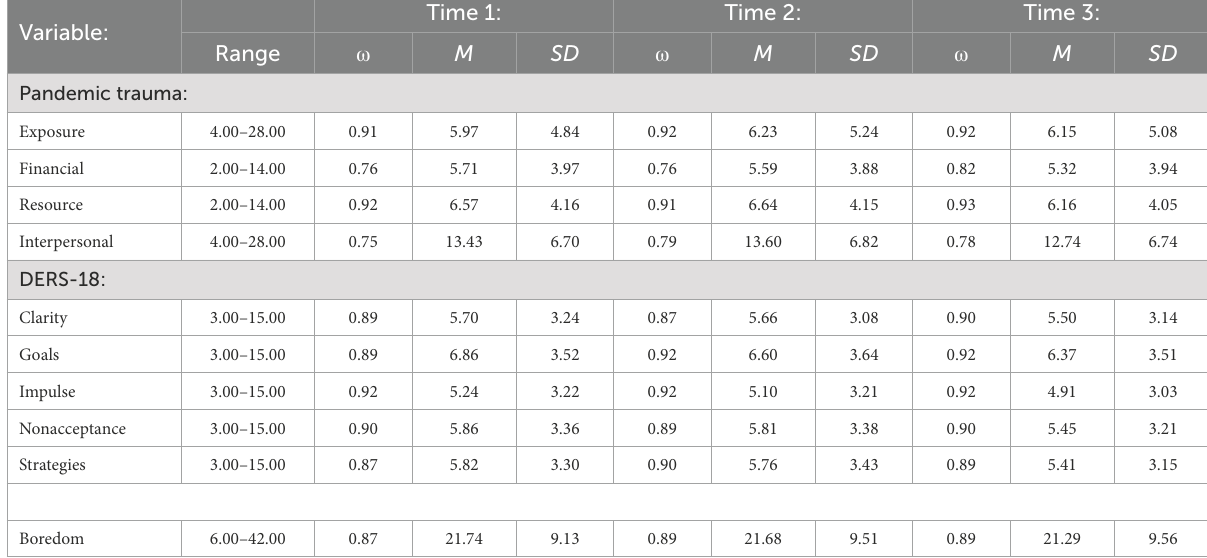
TABLE 2 Coefficient omega estimates and descriptive statistics for continuous measured variables at Times 1, 2, and 3 ( N = 345).